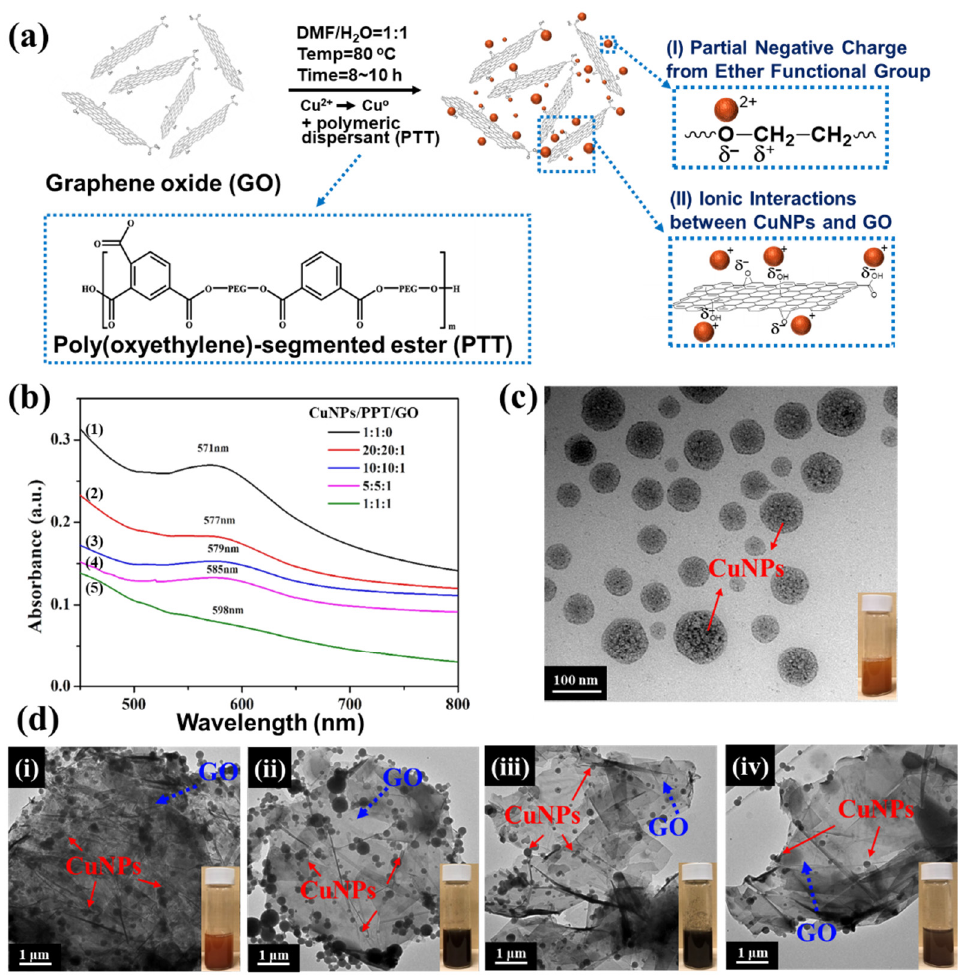
Figure 2. ( a ) Schematic illustration of the in situ reduction and dispersion mechanism of CuNPs on GO. ( b ) UV-vis spectrum of CuNPs/PTT/GO, CuNPs/PTT/GO ratio. (1) 1:1:0, (2) 20:20:1, (3) 10:10:1, (4) 5: 5:1 and (5) 1:1:1. ( c ) TEM and digital images of reduced CuNPs when mixed with PTT at a ratio